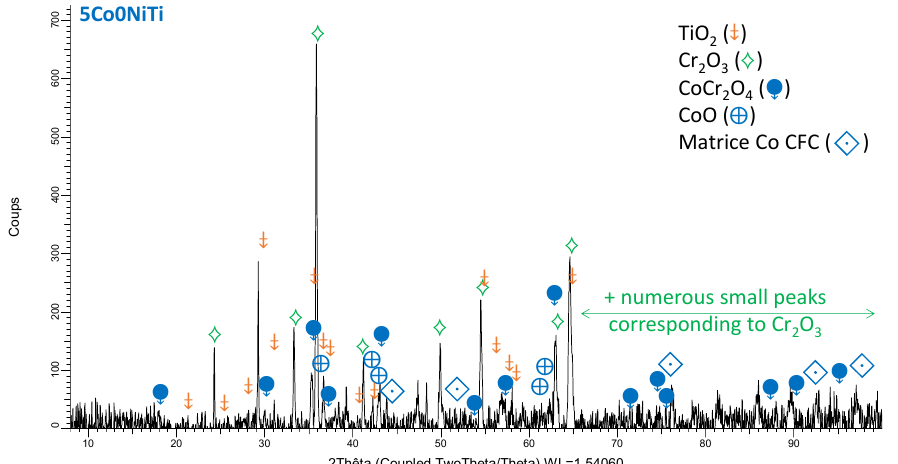
Figure 3. Diffractogram acquired on one side of the oxidized 5Co0NiTi sample.